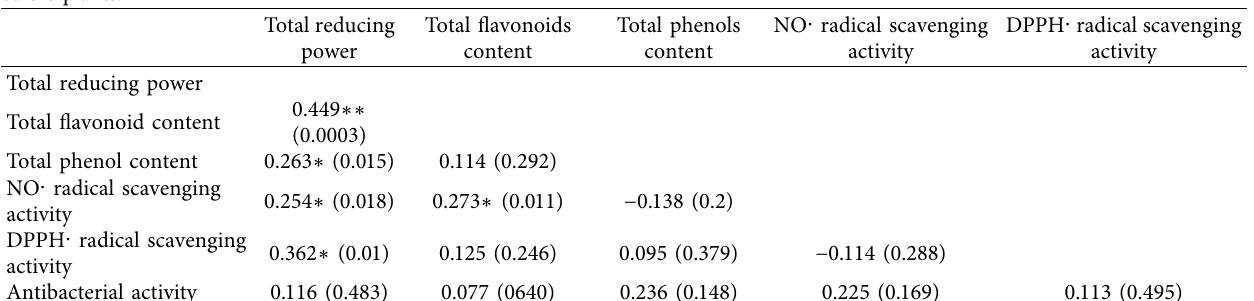
Table 7: Correlation between different antioxidant activity and antibacterial parameters of the methanol extracts of thirteen antibacterial edible plants.